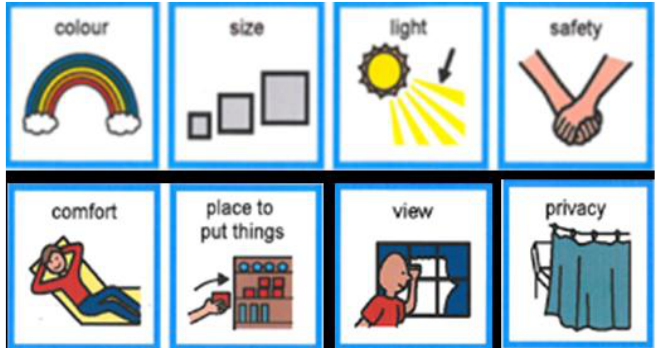
Figure 4. Talking Mat symbols (Options) for Aspects of Place Experience. The Picture Communication Symbols ©1981–2012 Dynavox Mayer Johnson are used with permission. All rights reserved